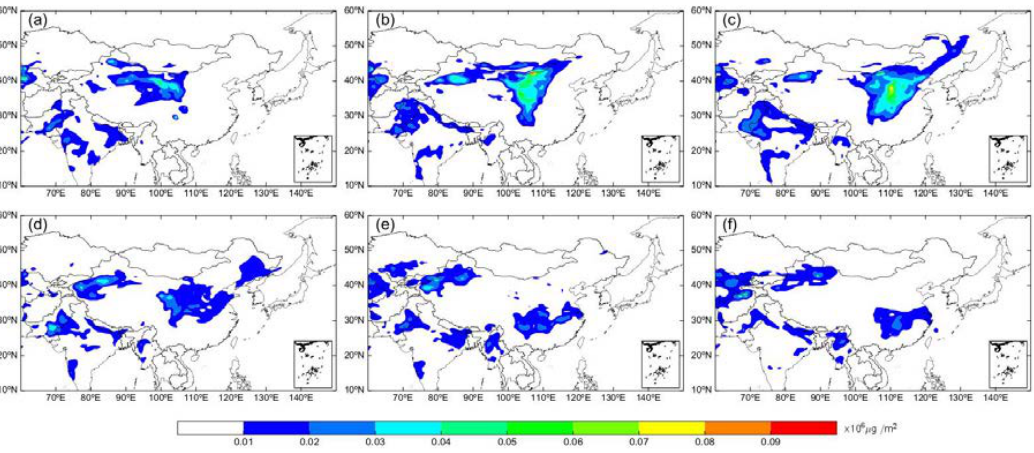
Figure 13. Spatial distribution of daily dust aerosol dry deposition on 2–7 May 2017(sub-graph a to f respectively describe dust aerosol dry deposition on 2–7 May 2017).